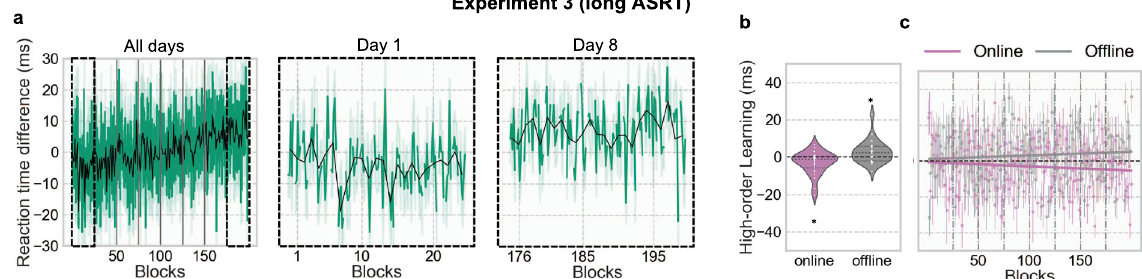
Fig. 4 High-order rule learning occurs during rest periods. a Average high-order rule learning (RT difference between pattern and random- high trials) per block (black line) and per bin (green line) for Experiment 3 (long ASRT). For better visualization, a zoom-in for day 1 and day 8 is represented. b Average online and of fl ine high-order rule learning across all blocks for Experiment 3 (long ASRT). c Online and of fl ine high- order rule learning across all blocks and with a linear fi t for Experiment 3. Signi fi cance is noted by a single asterisk (*) for p value <0.05. Note that higher values mean greater learning. Error bars represents standard